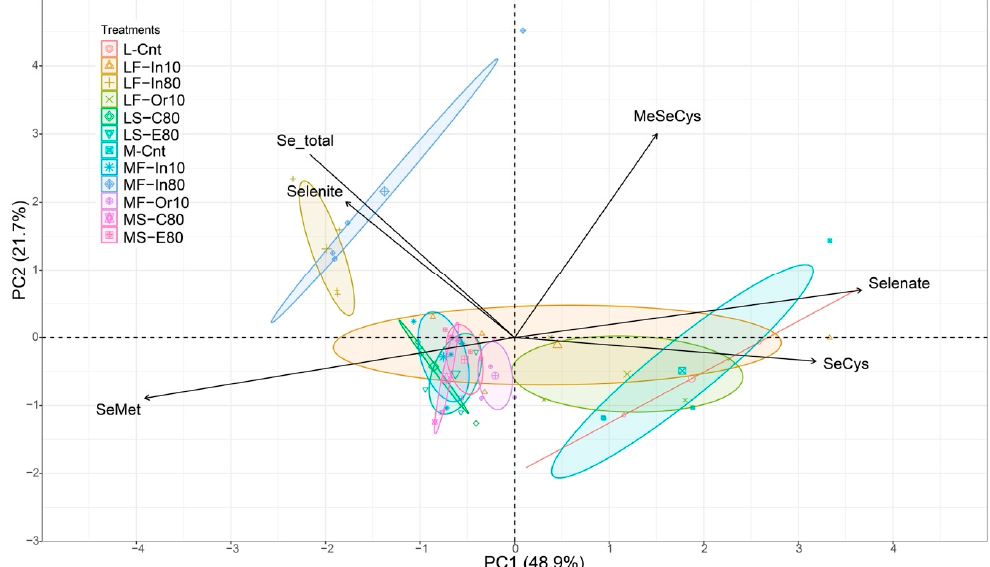
Figure 3. Principal component analysis. Abbreviations: SeMet = selenomethionine; MeSeCys = methyl selenocysteine; SeCys = selenocysteine. Genotype: L = Lança and M = M5917; Se application: F = foliar and S = soil; Se source: In = Se inorganic, Or = Se organic, C = C-MAP + Se, and E = E-MAP + Se; Rate: 10 = 10 g ha − 1 and 80 = 80 g ha − 1 ; Cnt = control.